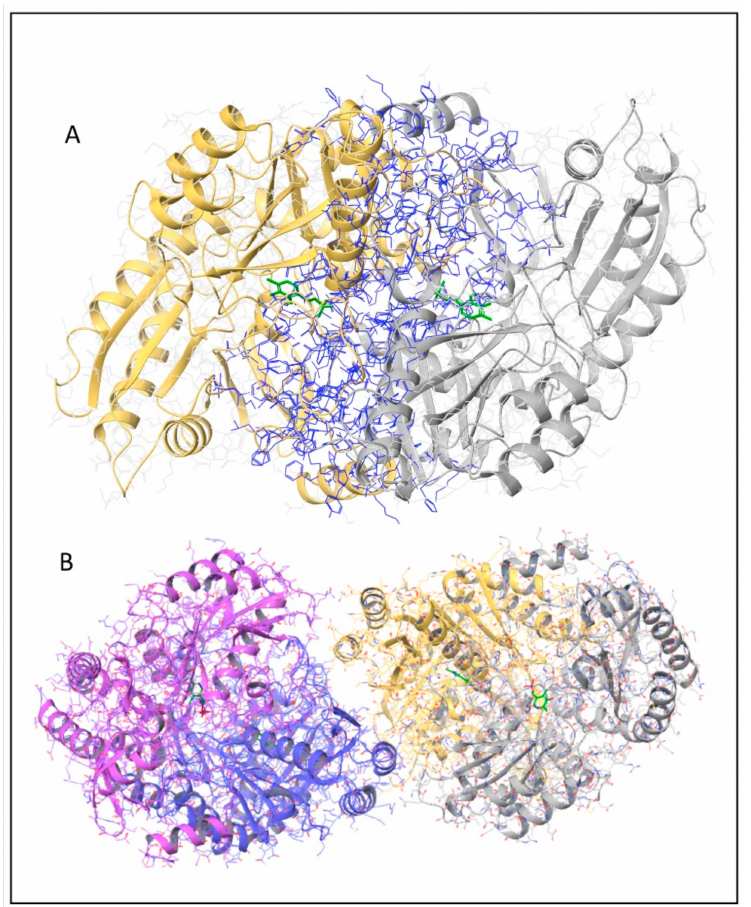
Figure 1. Dimeric and tetrameric hOAT structures. Cartoon representation of human hOAT structure; the protein chains are differently colored and the PLP molecules are represented as green sticks. ( A ) OAT dimeric structure in which all the interface residues are highlighted in blue. ( B ) OAT tetrameric structure in which the two dimers are colored magenta/blue and yellow/gray, respectively. The image was generated by Maestro v13.3 software (Schrödinger, New York, NY,